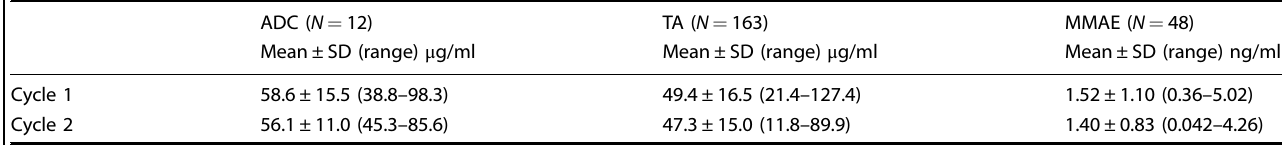
Table 4. Post-infusion serum concentrations.